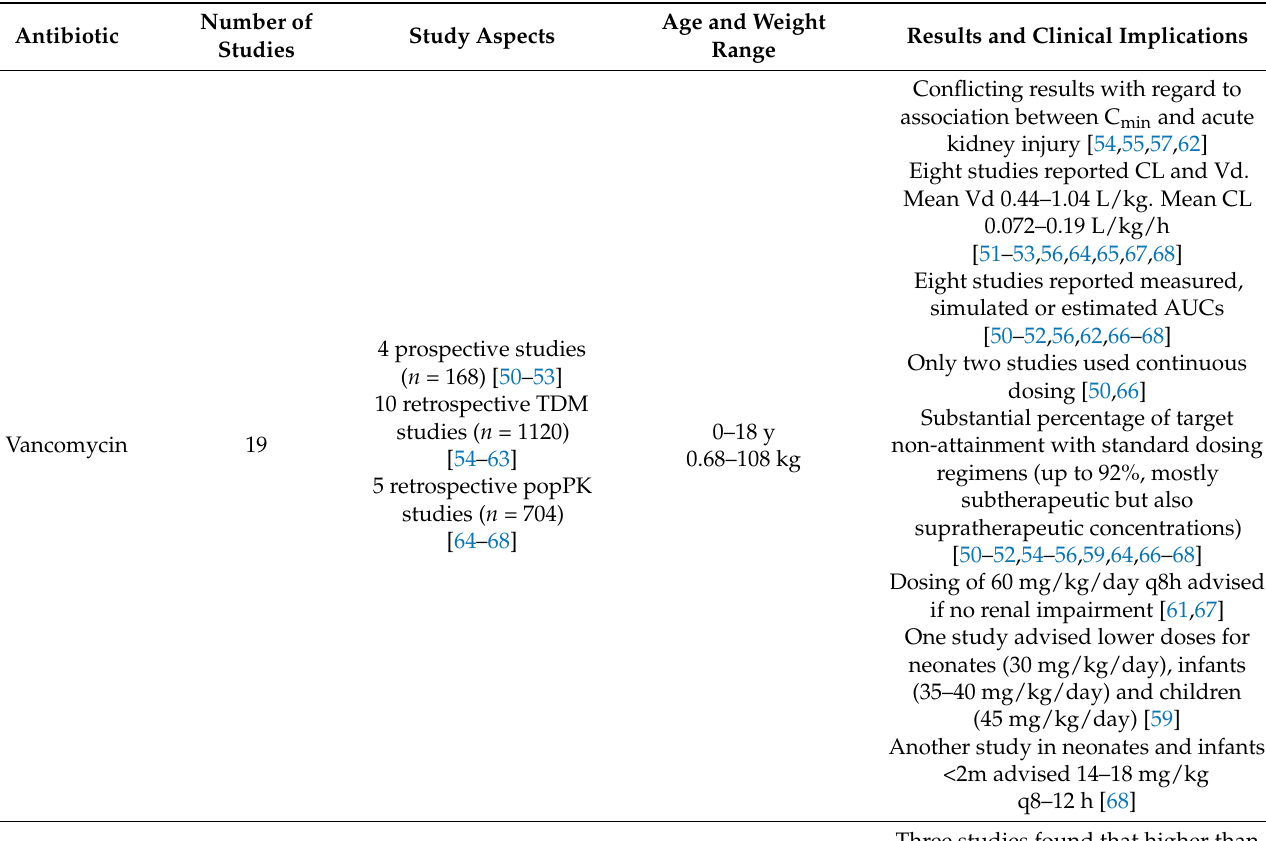
Table 3. Summary of all antibiotic PK studies performed in critically ill